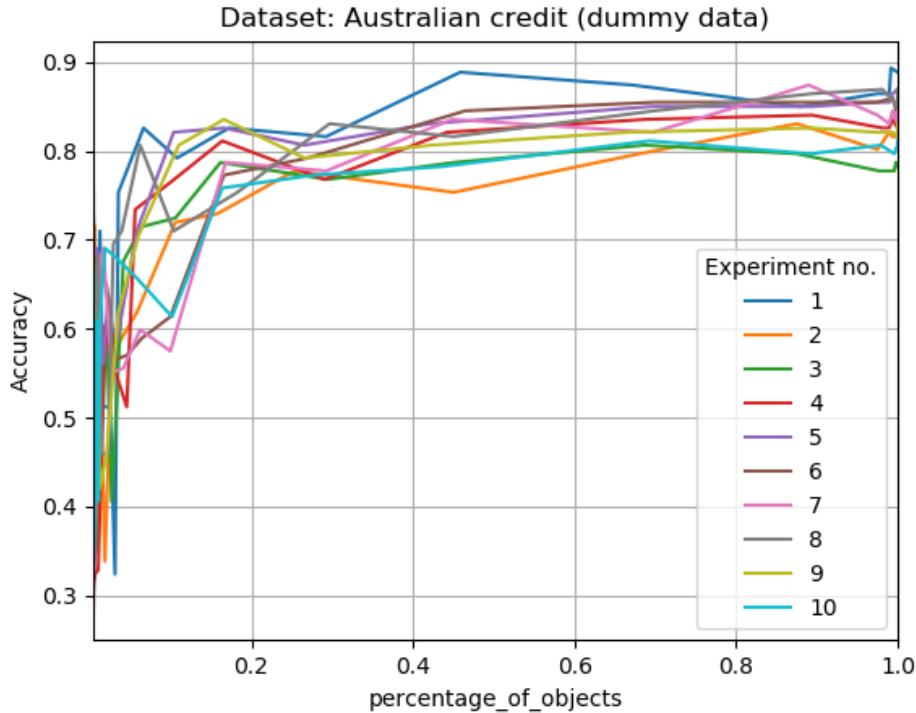
Figure 9. Results for 10 learning cycles, using 10 splits; for Australian credit data set converted to dummy variables (after conversion to dummy variables its 35 attributes); In ‘percentage of objects’ ax, we have the percentage size of granulated data vs accuracy of classification in ‘Accuracy’ ax; in. The results are not perfectly evenly matched or at the same points on the x-axis, due to the fact that the size reduction levels of the training systems varied.